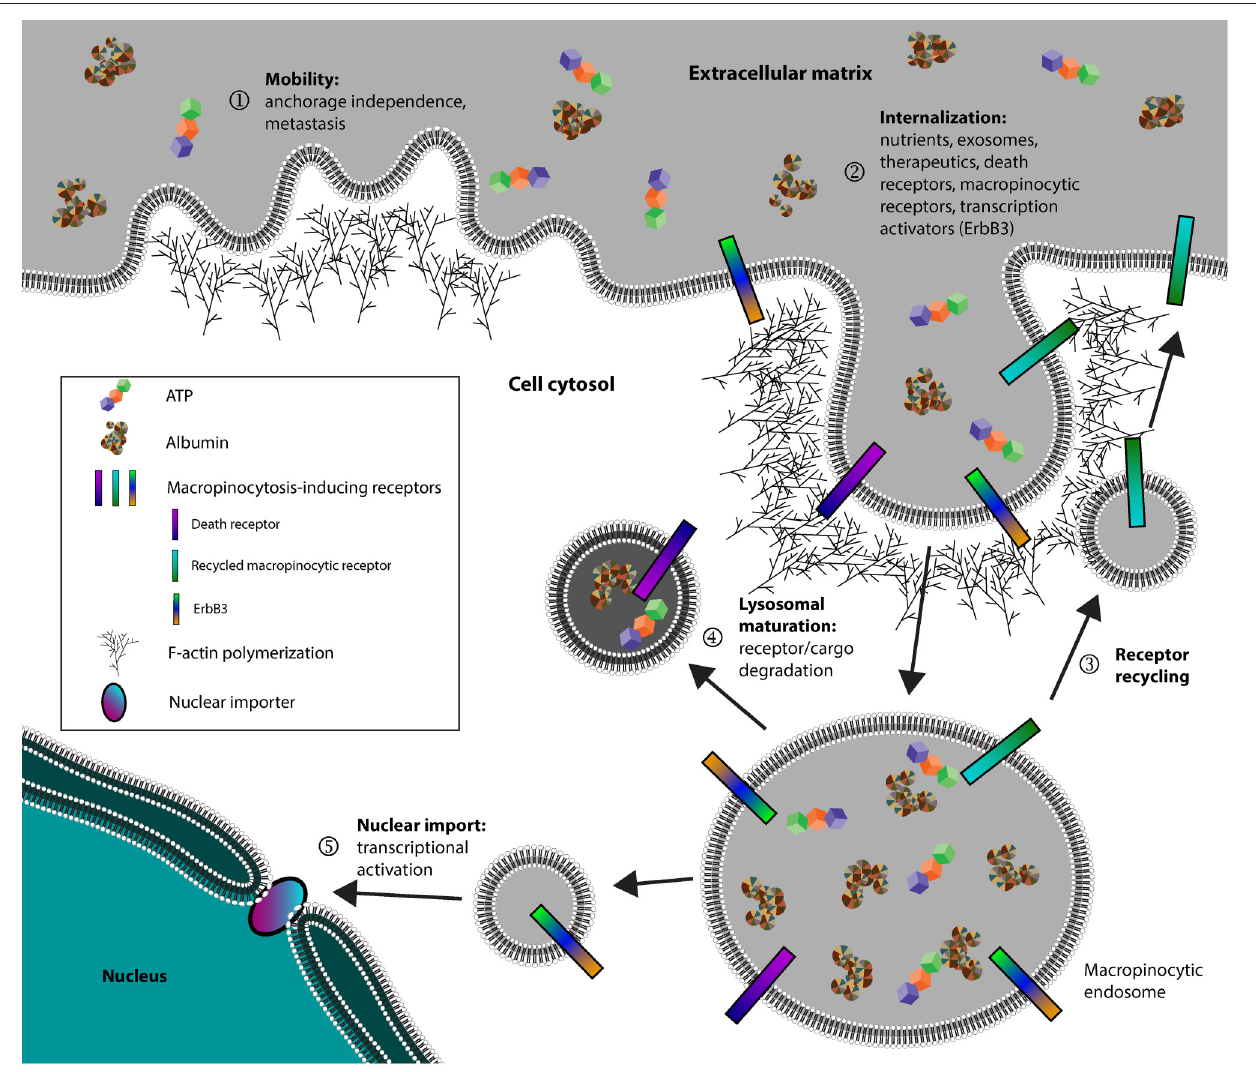
FIGURE 1 | Cancer cells exploit macropinocytosis to fulfill diverse functions. (1) Cancer cells can utilize membrane ruffles, a hallmark of macropinocytosis, to establish mobility and facilitate both anchorage independence and metastasis. (2) Cancer cells internalize metabolic nutrients, surface receptors, and transcription activators. (3) Receptors involved in activating macropinocytosis are recycled back to the plasma membrane. (4) Non-recycled protein cargo and receptors are degraded through the lysosomal network or in some instances, (5) certain receptors such as ErbB3 can be targeted for nuclear import to activate transcription.